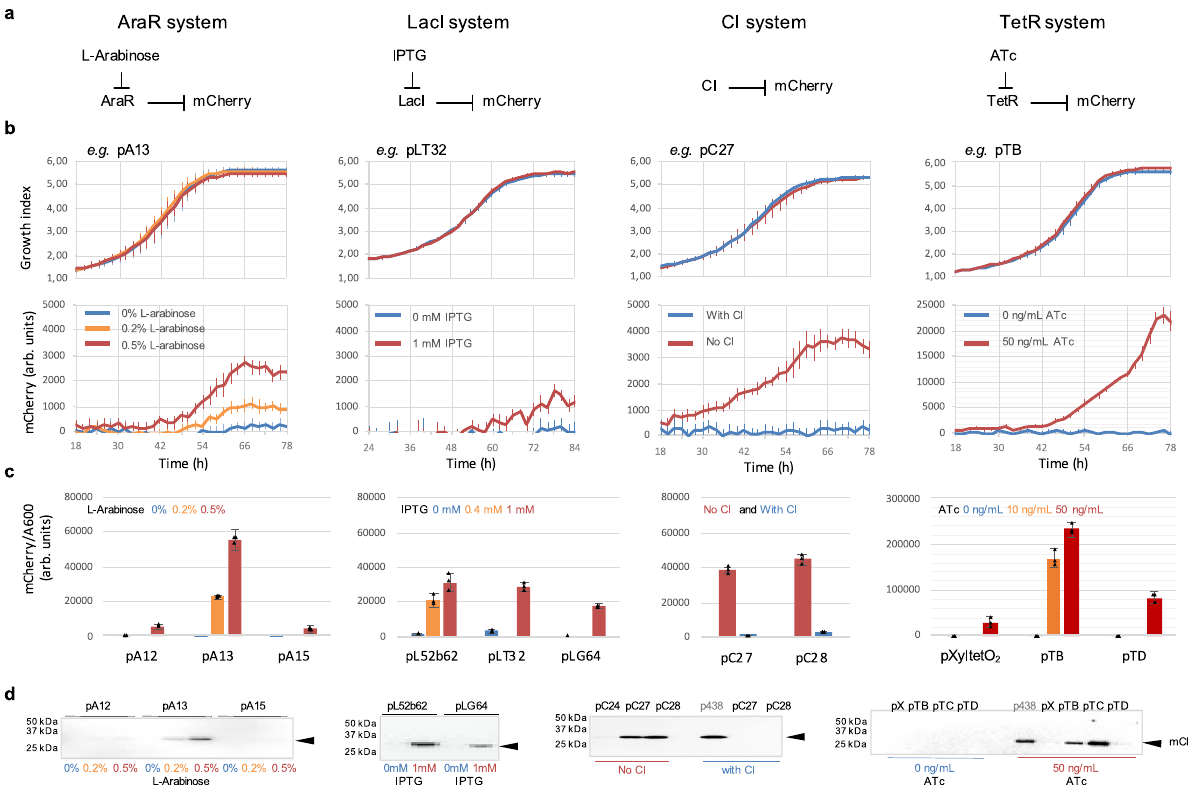
Fig. 1 First genetic toolkit for Mycoplasma . a Schematic representation of the inducible systems based on the AraR repressor ( L -arabinose inducer), LacI repressor (IPTG inducer), CI repressor, TetR repressor (ATc inducer). Blunt arrows indicate repression. b Induction time-course results for one synthetic promoter selected for each repressor system. The upper graphs show synchronised growth (growth index as the ratio Abs430 nm/Abs560 nm) between uninduced (blue) or induced (red and orange) cultures with the corresponding inducer for each repressor. The lower graphs show the corresponding mCherry kinetics ( fl uorescence in arbitrary units; background subtracted for auto fl uorescence — see Methods). The mCherry expression depending on the inducer concentration was con fi rmed by Fluorimetry ( c ) and western blot ( d ) in the exponential phase (two days after induction) for several synthetic promoters in each repressor system. All results from mean values from three bio-replicates (black triangles show the values of each bio-replicates). Error bars indicate standard deviation. Source data are provided as a Source Data fi